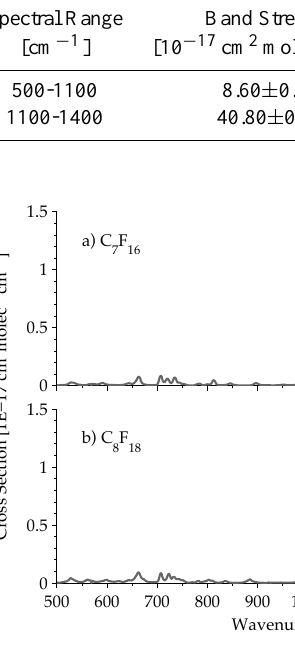
Fig. 3. Average absorption cross-section for (a) C 7 F 16 and (b) C 8 F 18 measured at 1cm − 1 resolution and 296K. The spectra were measured over a range of 500–4000cm − 1 , although only the main spectral features are